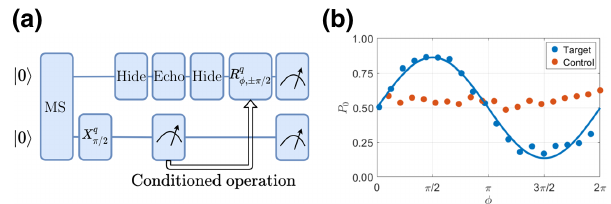
FIG. 10. Coherent feedback on an entangled state. (a) A two- qubit maximally entangled Bell state is prepared using an MS gate, followed by a π/ 2 pulse on the control qubit. Then, the target qubit is hidden, a measurement is performed along with echo pulses, and the target qubit is mapped back onto the optical qubit. A π/ 2 pulse with a phase φ − π/ 2 or φ + π/ 2 is applied conditioned on the measurement result. (b) The qubit population as a function of φ . Due to the initial entanglement, the measure- ment collapses the target qubit onto a superposition state defined by the control-qubit measurement result. This phase is effectively measured by applying the π/ 2 pulse. We measure an 0.862(18) success